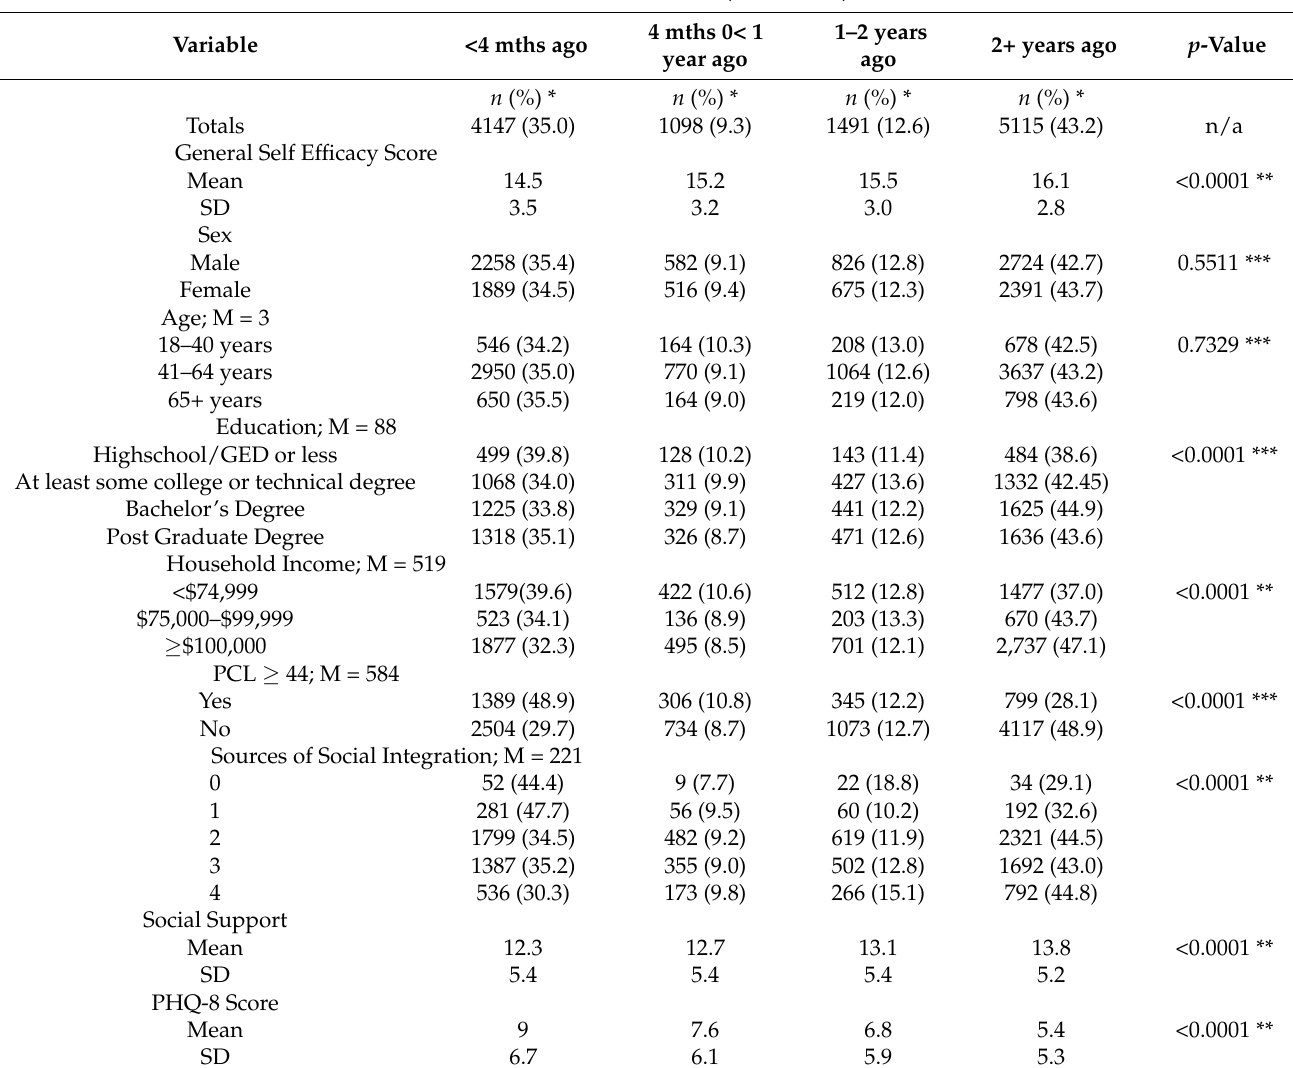
Table 2. Sociodemographic and Mental Health Characteristics of World Trade Center Health Registry Enrollees Who Had at Least One Session of Counselling or Therapy After 9/11, Stratified by Time of Most Recent Counselling or Therapy Visit (i.e., Outcome #1), 2015 to 2016 ( n = 11,851). Time of Most Recent Counselling or Therapy